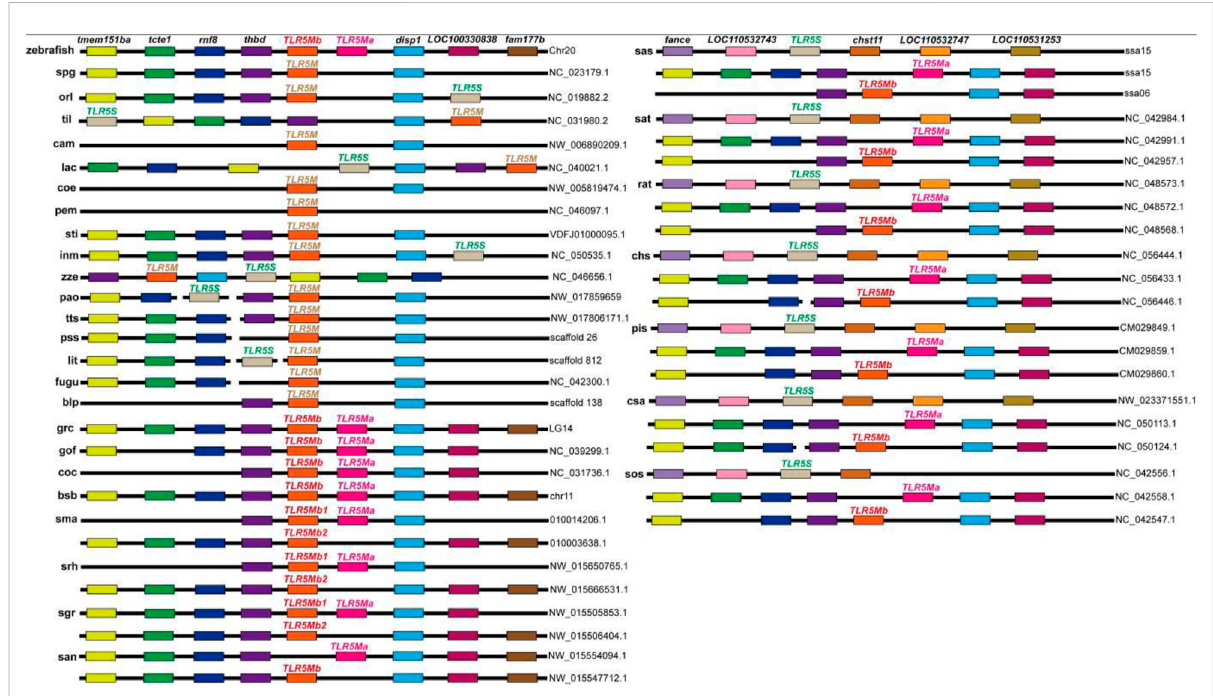
FIGURE 2 Syntenyanalysesofthechromosomelociharboring TLR5 genesin fi shes.Differentcoloredrectanglesrepresentdifferentgeneloci.Somegene loci near TLR5 present conserved synteny in these examined fi shes. Detailed abbreviation of each species is available in Table